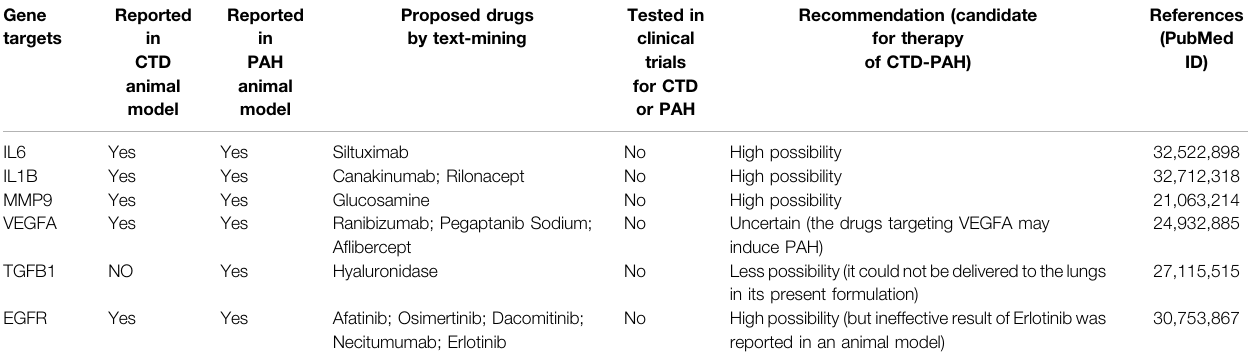
TABLE 2 | Comprehensive recommendation of promising drugs for the treatment of CTD-PAH. Gene